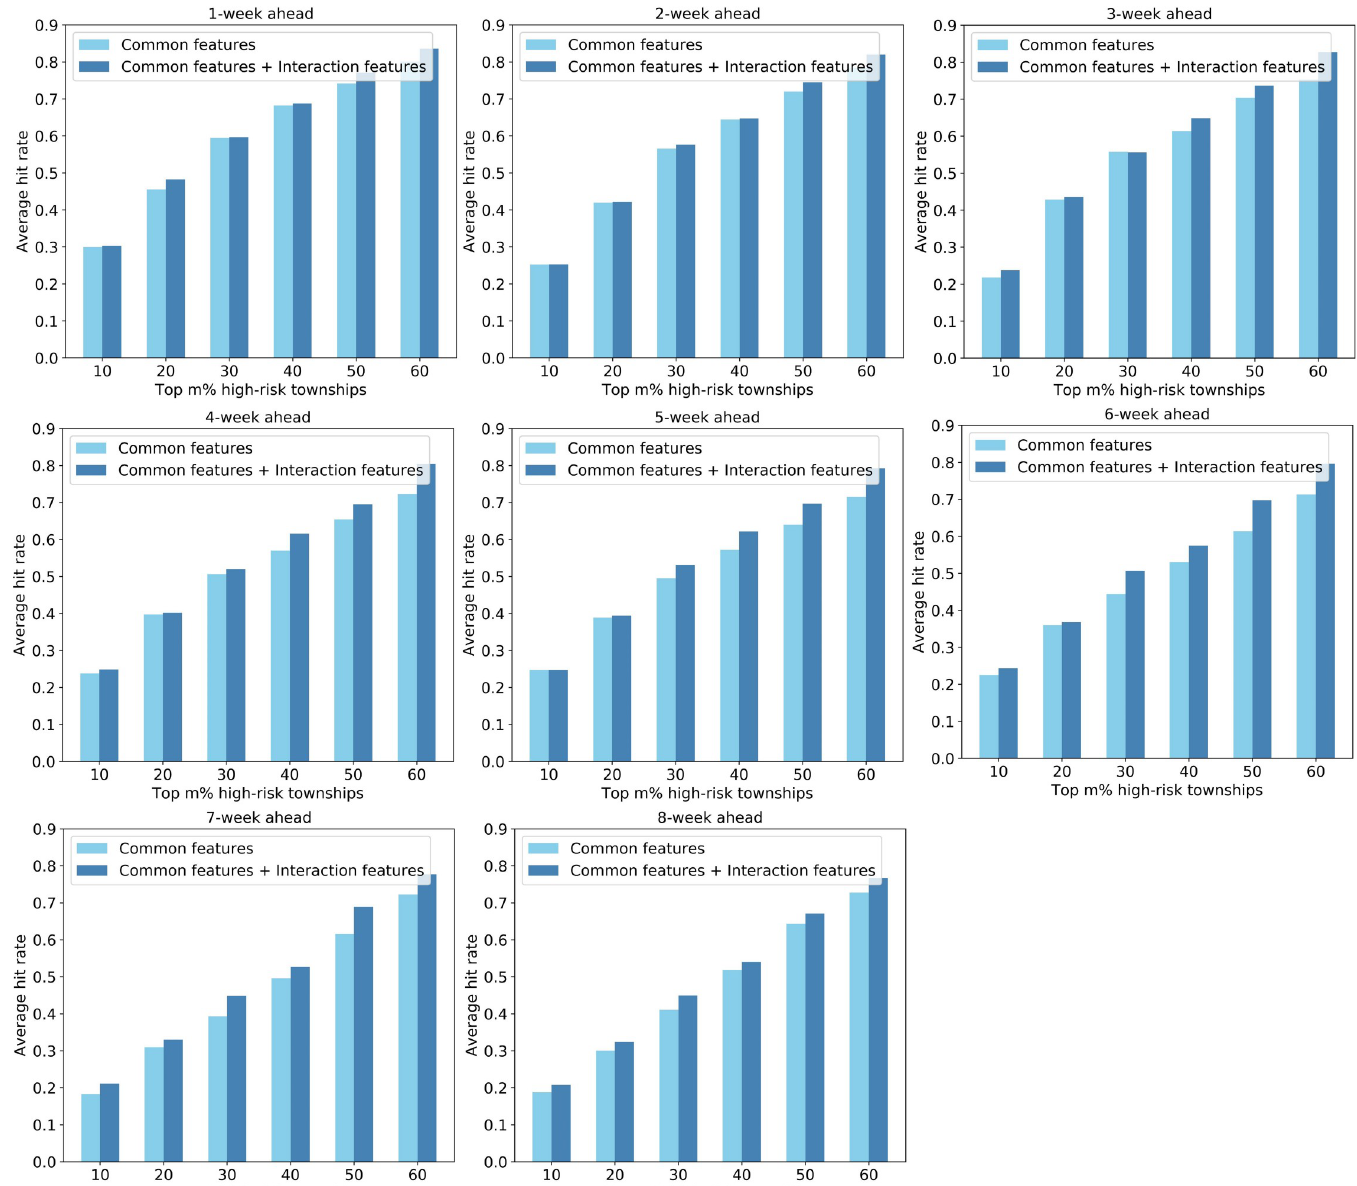
Fig 12. Performance comparison of the LASSO-based models with and without interaction features based on the hit rate metric.